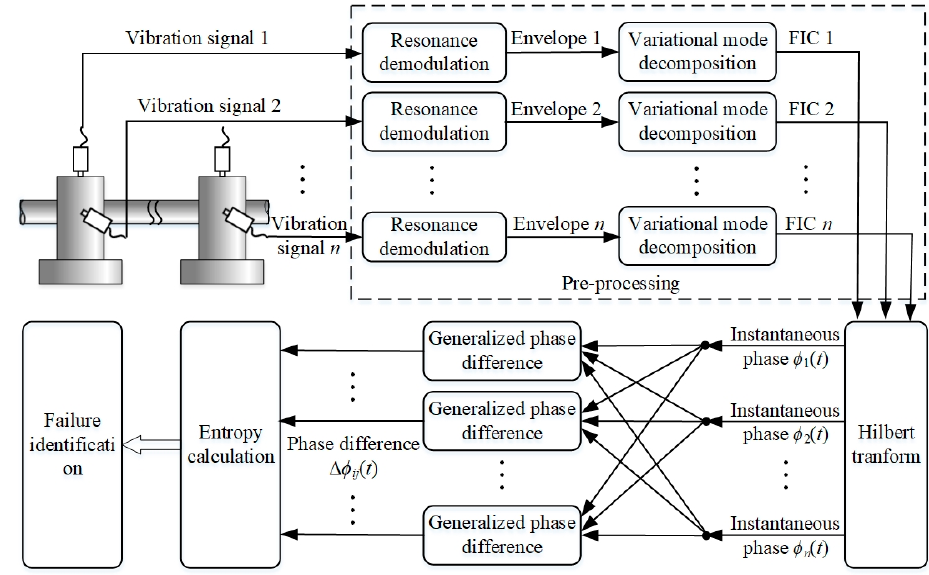
Figure 2. Schematic of phase synchrony analysis (PSA).